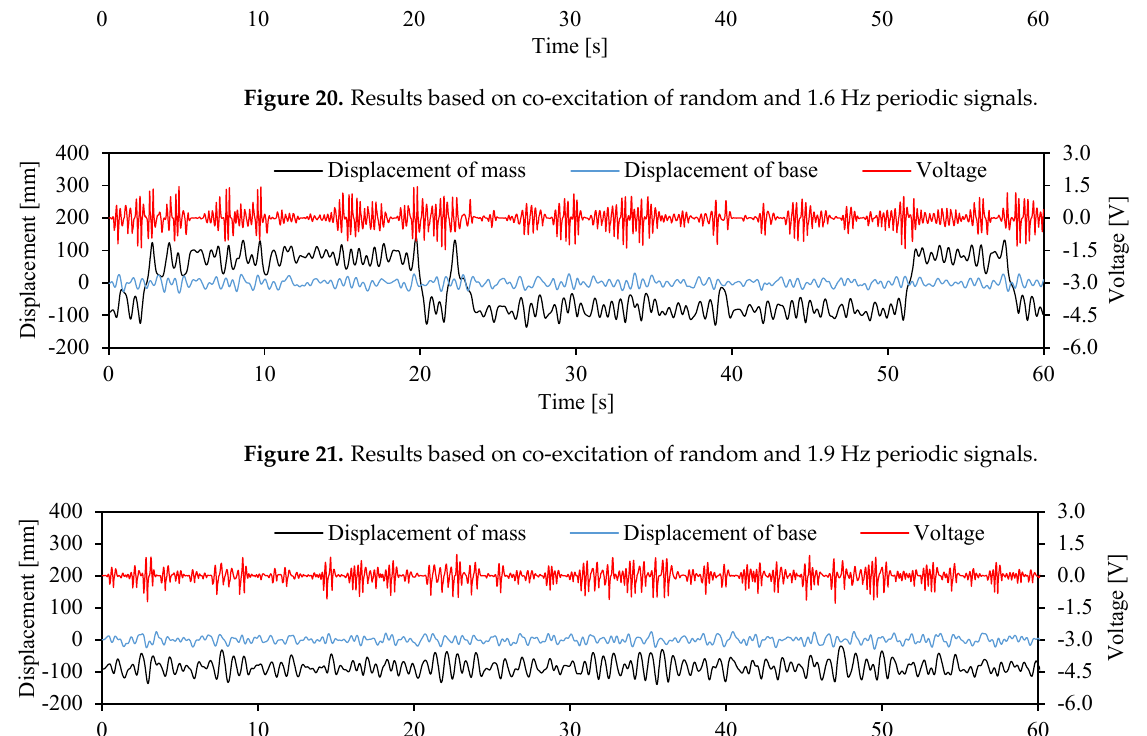
Figure 19. Results based on co-excitation of random and 1.3 Hz periodic signals.